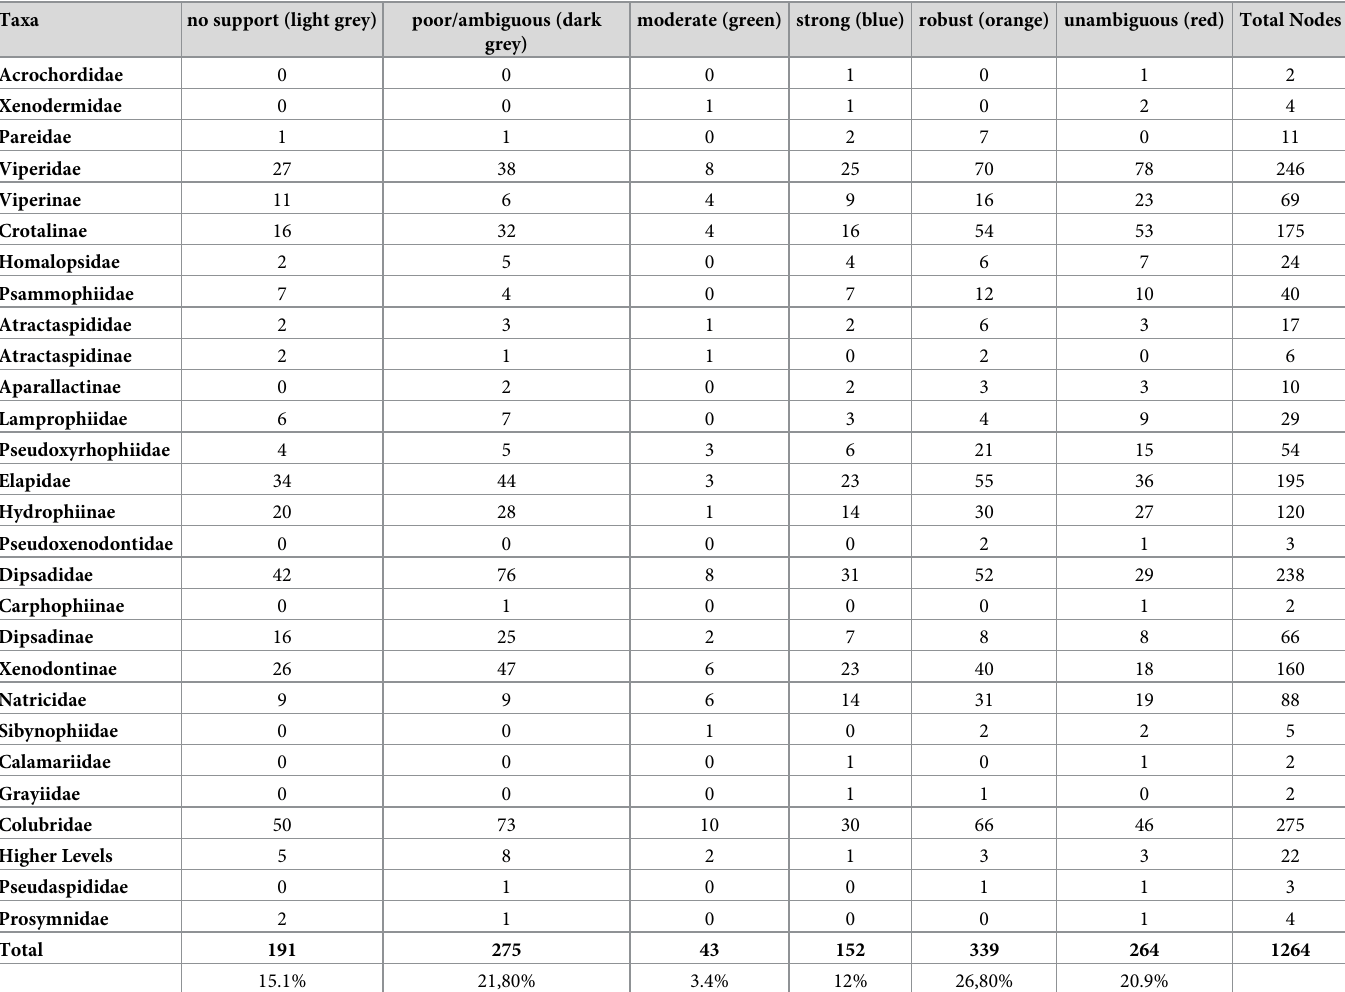
Table 1. Numbers of inferred clades in each category of combined FBP and SHL support